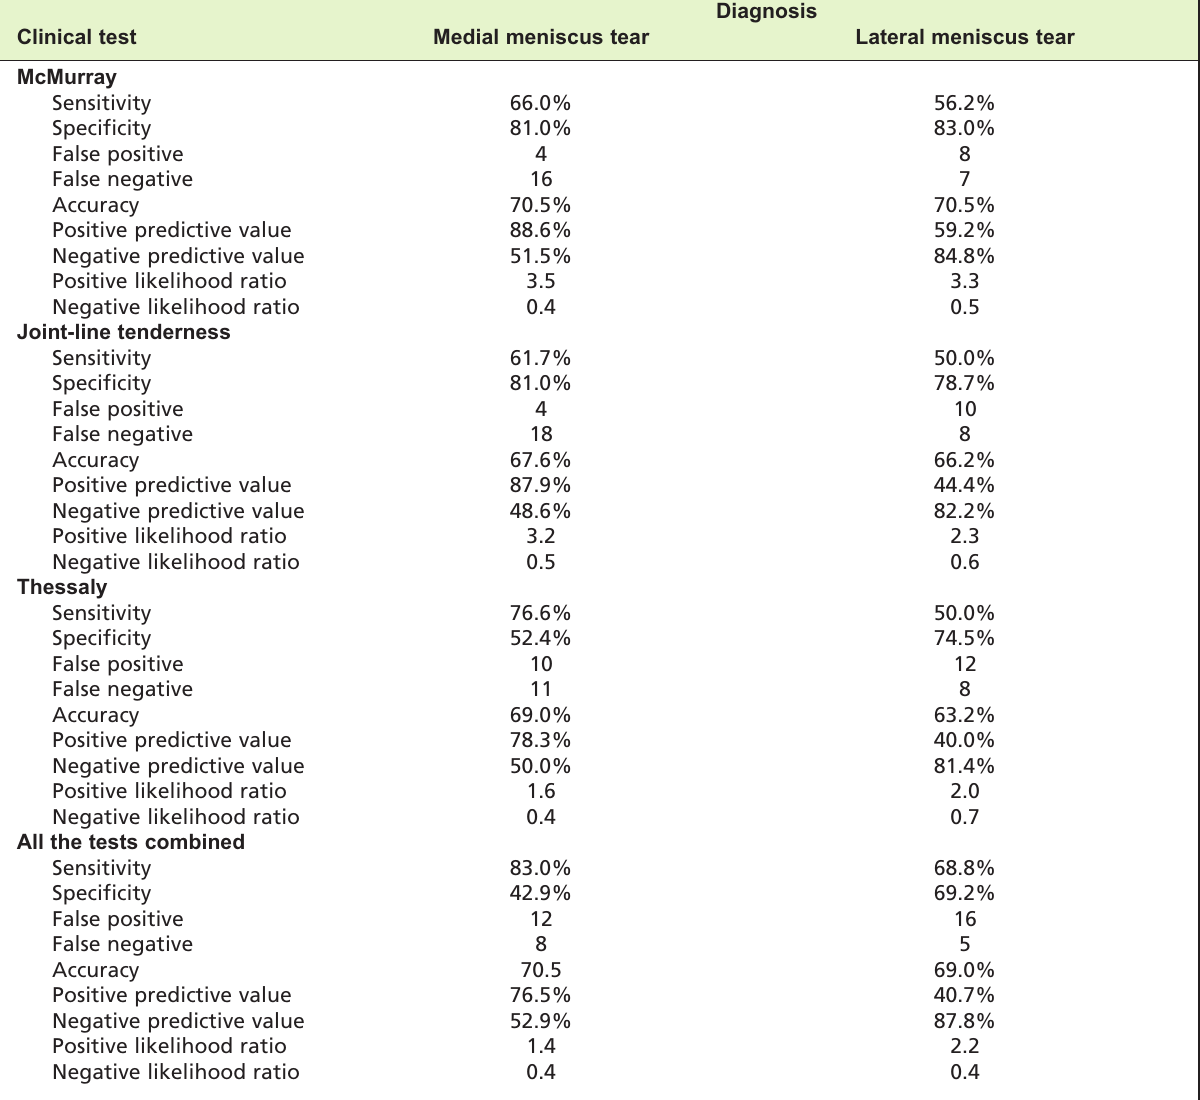
The diagnostic parameters of the three clinical tests with arthroscopy as the gold standard of the diagnosis (N = 68) Table II: